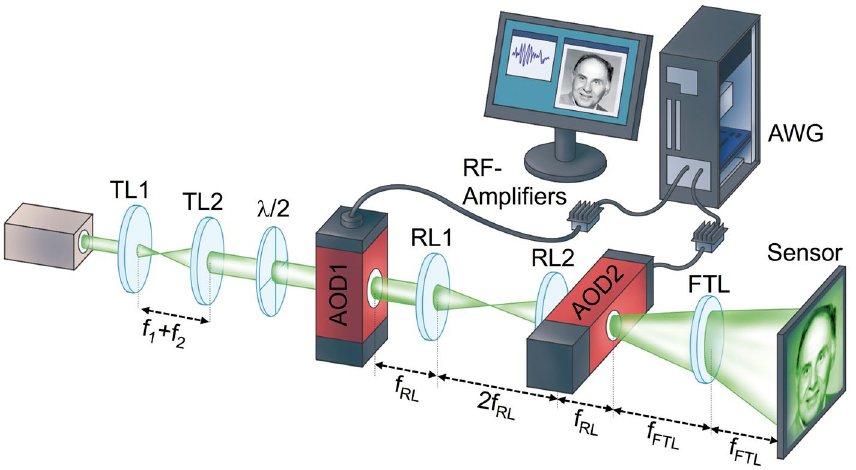
Figure 2. Conceptual setup of a holographic acousto-optic light modulation (HALM) system. A laser beam is successively modulated by a first acousto-optic deflector that displays a computer-generated hologram, and